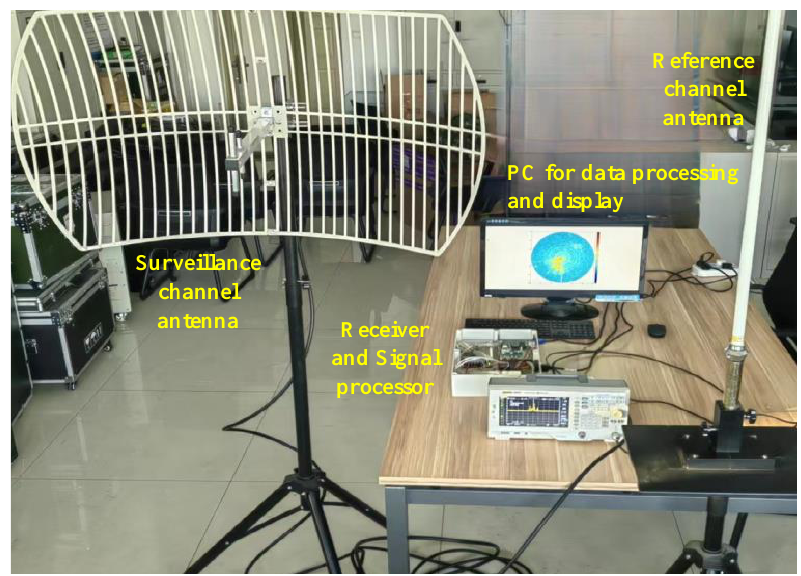
Figure 8. The physical photos of the experimental equipment.